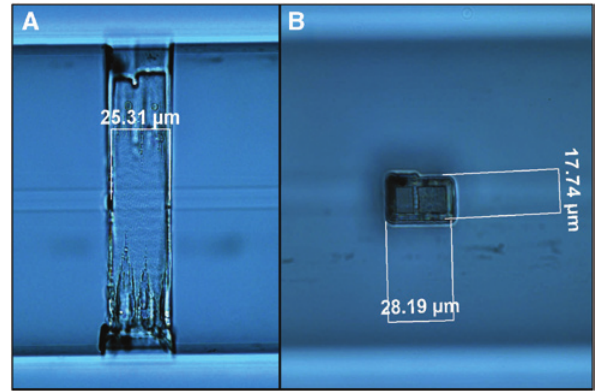
Figure 12: Microscopic pictures of the femtosecond laser fabricated microfluidic chamber devices. Adapted from [211].